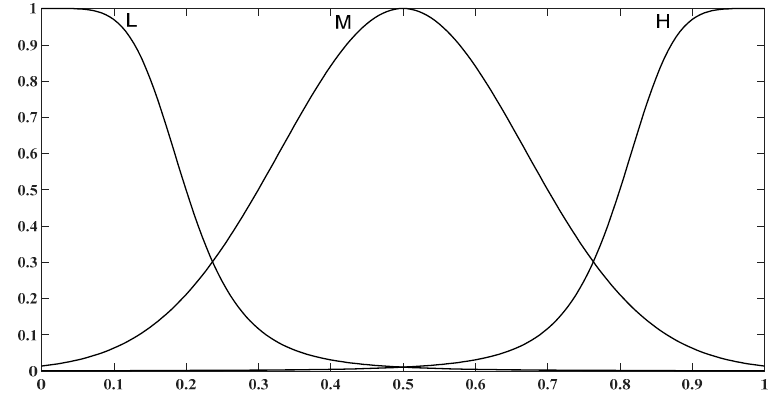
Figure 3. Initial membership functions for all of fuzzy system inputs.